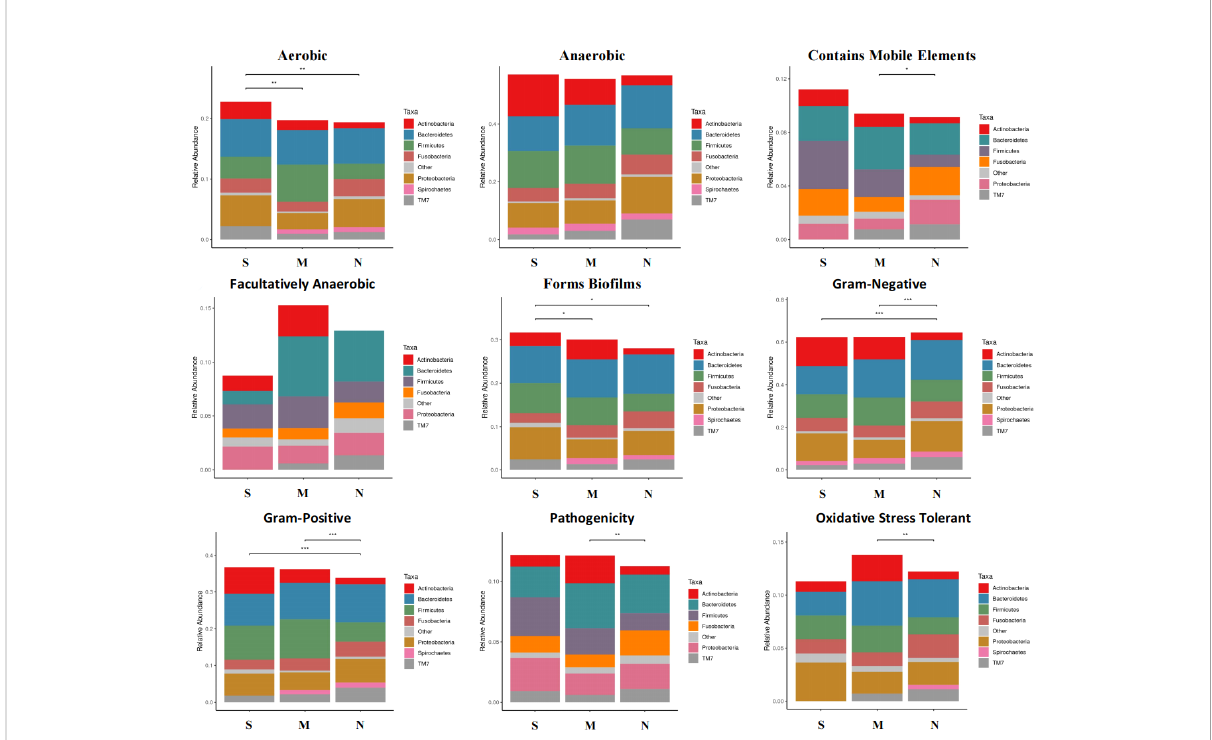
FIGURE 5 Microbial phenotype analysis of all three groups. The BugBase analysis was used to reveal the characteristics of the microbial phenotype of all groups, which was divided into nine phenotypic classi fi cations. The above fi gure shows the relative abundance and comparison of bacterias with different groups in different phenotypes. Turkey-HSD analysis was used. * p value< 0.05, ** p value< 0.01, *** p value<